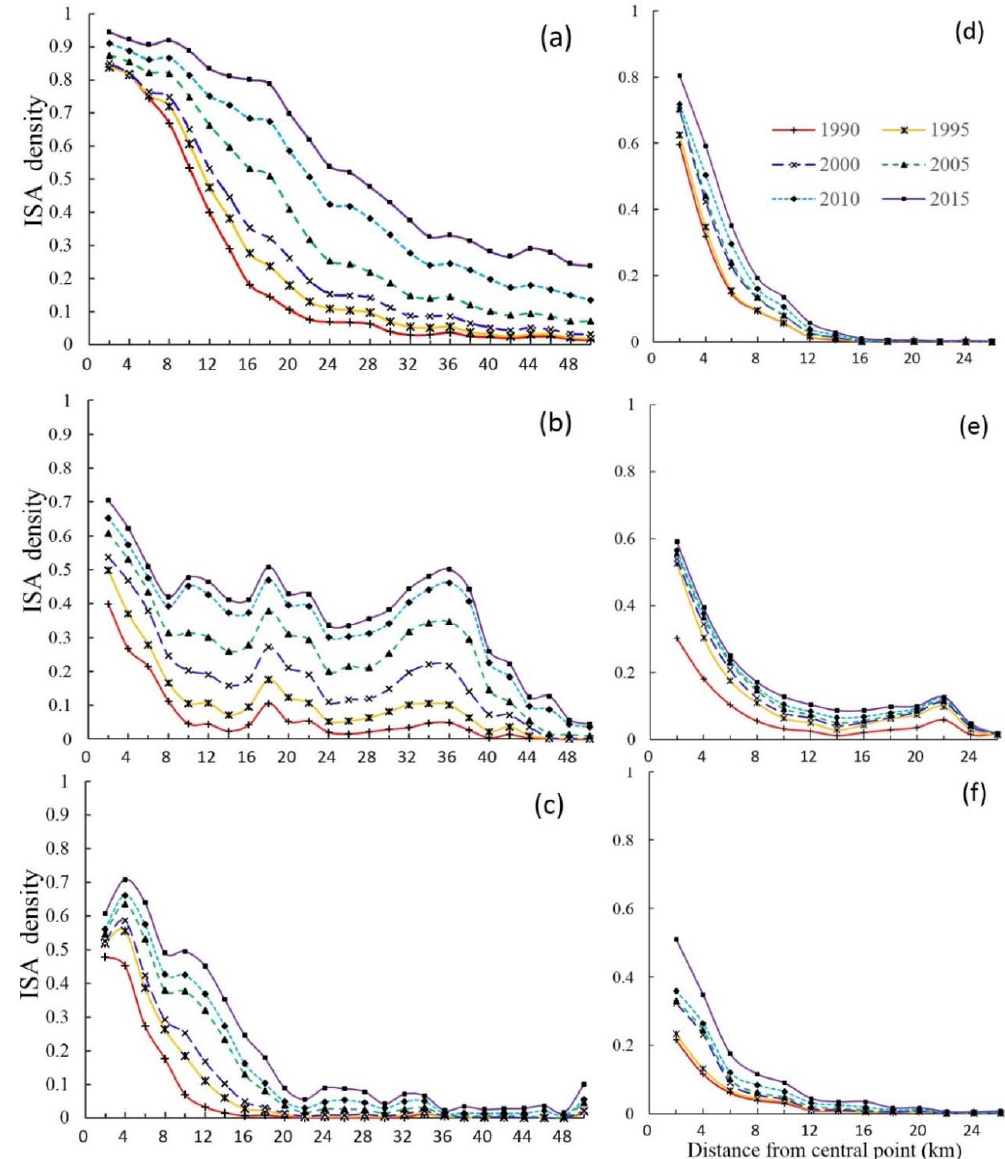
Figure 6. Comparative analysis of the ISA density distributions along the buffer zones among six Asian metropoles; ( a ) Shanghai, ( b ) Shenzhen, ( c ) Ho Chi Minh City, ( d ) Ulaanbaatar, ( e ) Lanzhou, and ( f ) Vientiane.